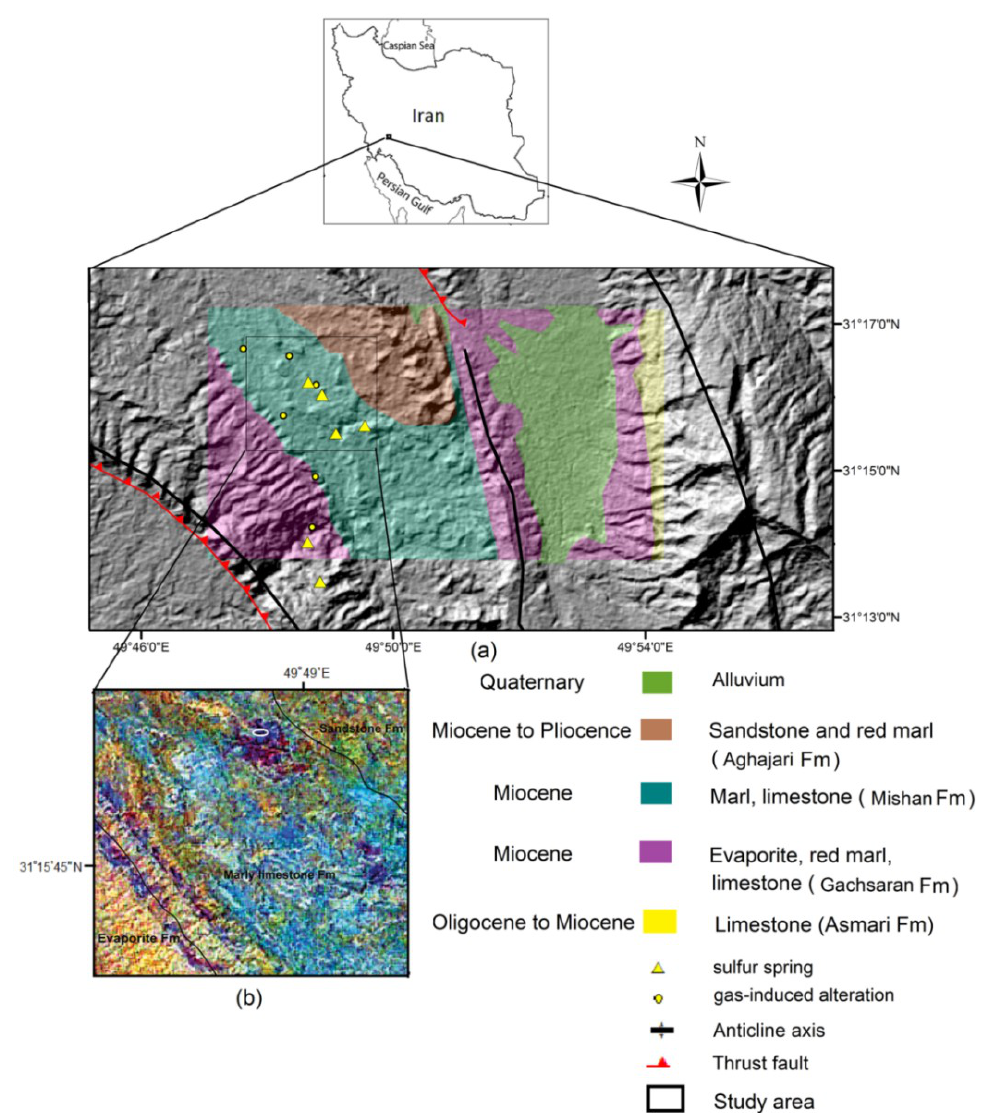
Figure 1. Study area ( a ) Geological map of the study area overlaid on the hill-shaded Advance Spaceborne Thermal Emission and Reflection Radiometer (ASTER) GDEM; ( b ) an ASTER (RGB: 468) false colour composite image of the study